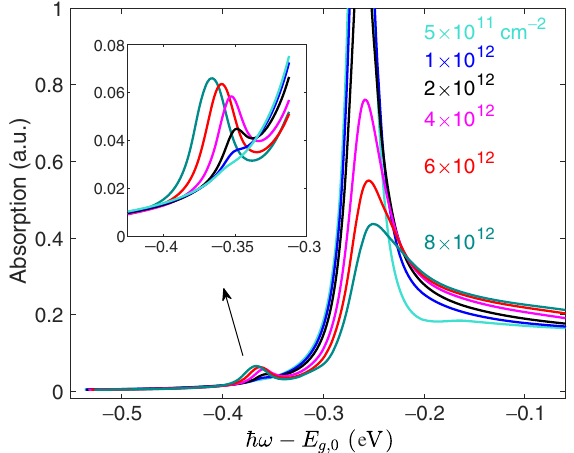
FIG. 8. The absorption spectrum of direct excitons in electron- doped ML-WX 2 after renormalization due to interaction with shortwave plasmons. A dynamical sideband emerges in the low- energy side of the absorption spectrum, as highlighted in the enlarged box. The sideband initially redshifts and intensifies when the electron density increases, showing saturated behavior at elevated